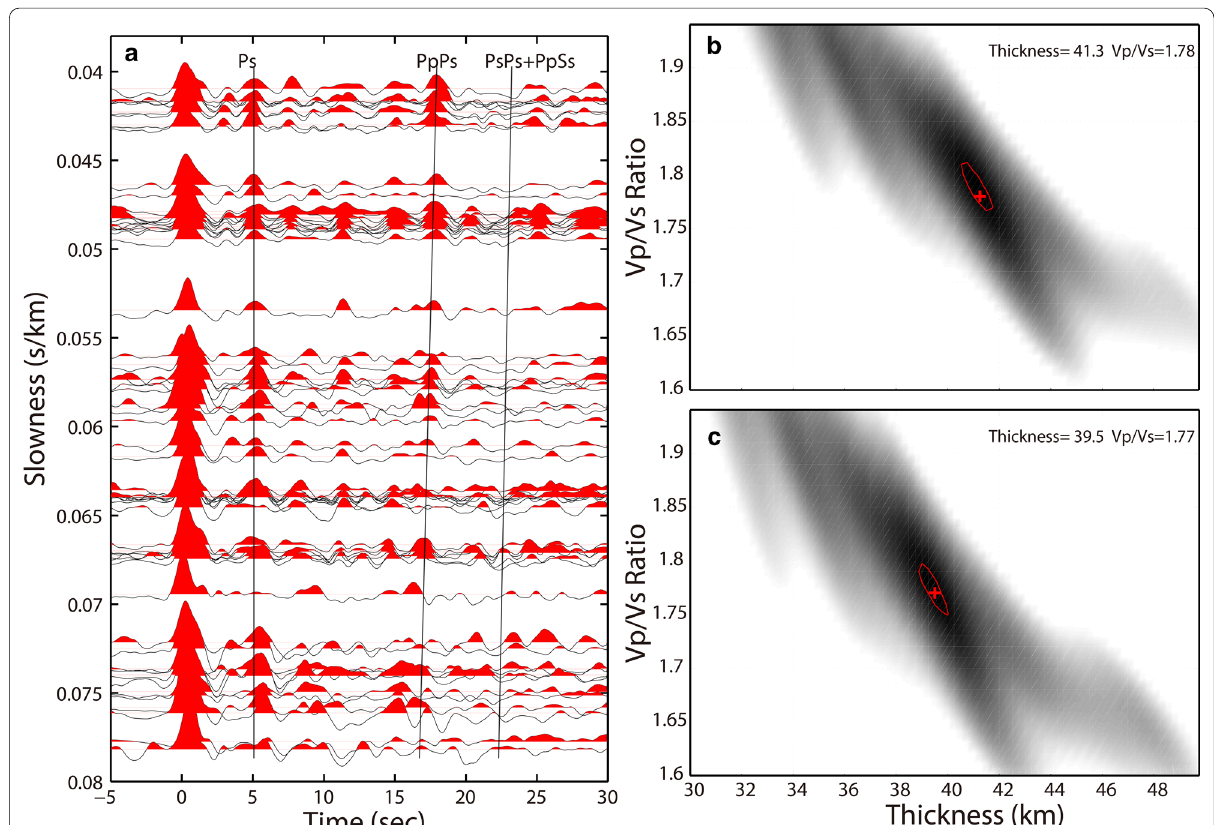
Fig. 4 Receiver functions and analysis of station 61124. a Receiver function sorted by slowness. b H - κ stacking without sediments. c H - κ stacking with